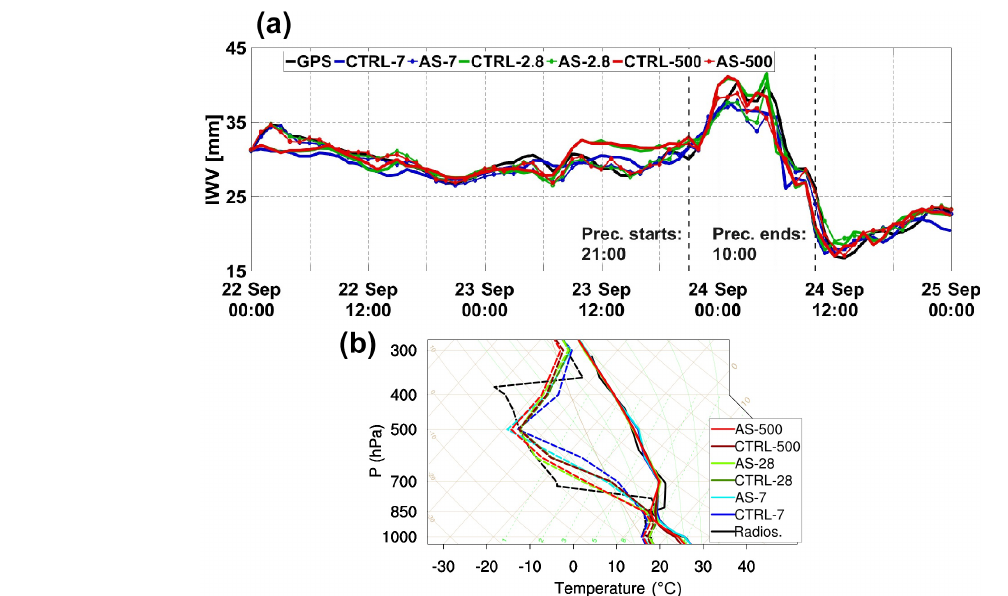
Figure 3. (a) Hourly IWV temporal evolution at a radiosonde site measured by the GPS and obtained with COSMO at the nearest grid points (b) Skew-T log at the same site on the 23 September 2012 at